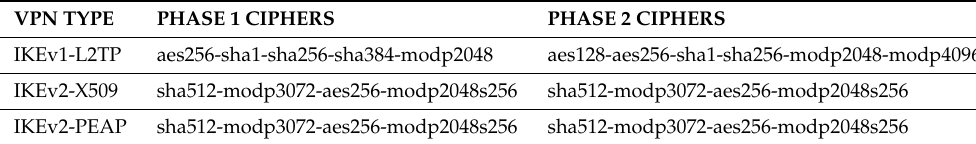
Table 6. Best data transmission efficiency algorithms of deployed scenarios.